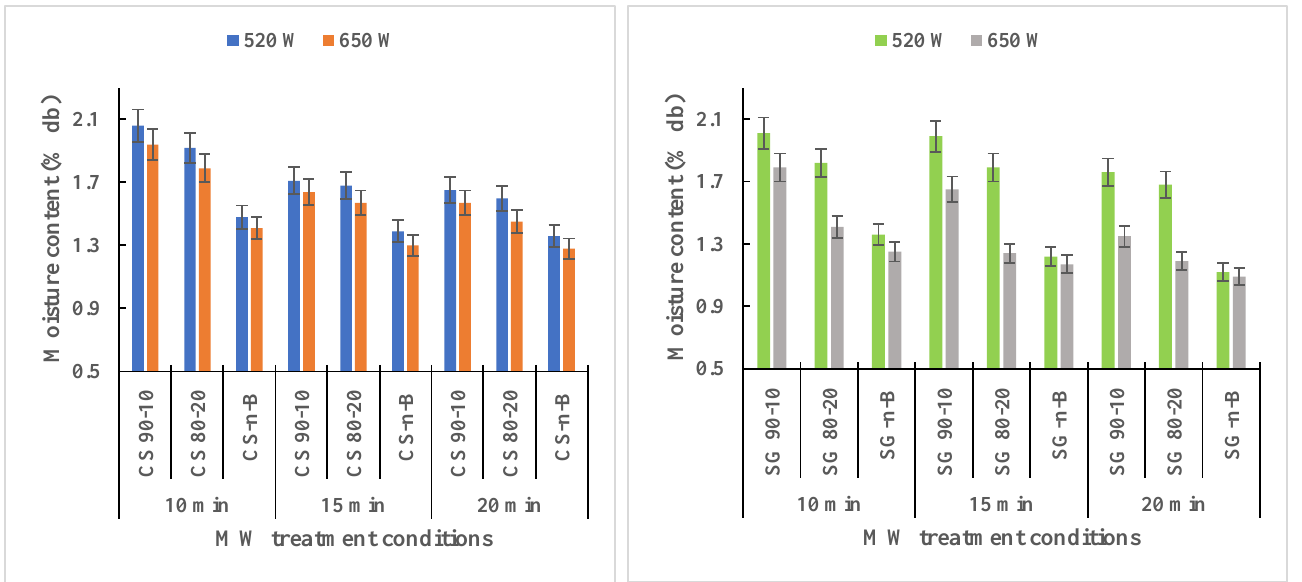
Figure 7. Moisture content of torrefied camelina straw and switchgrass with or without biochar at various residence times and microwave levels (520 W and 650 W). CS: camelina straw; CS-n-B: camelina straw-no-biochar; SG: Switchgrass; SG-n-B: Switchgrass-no-biochar. The first number after the biomass is % of biomass, and the second number is % of biochar.